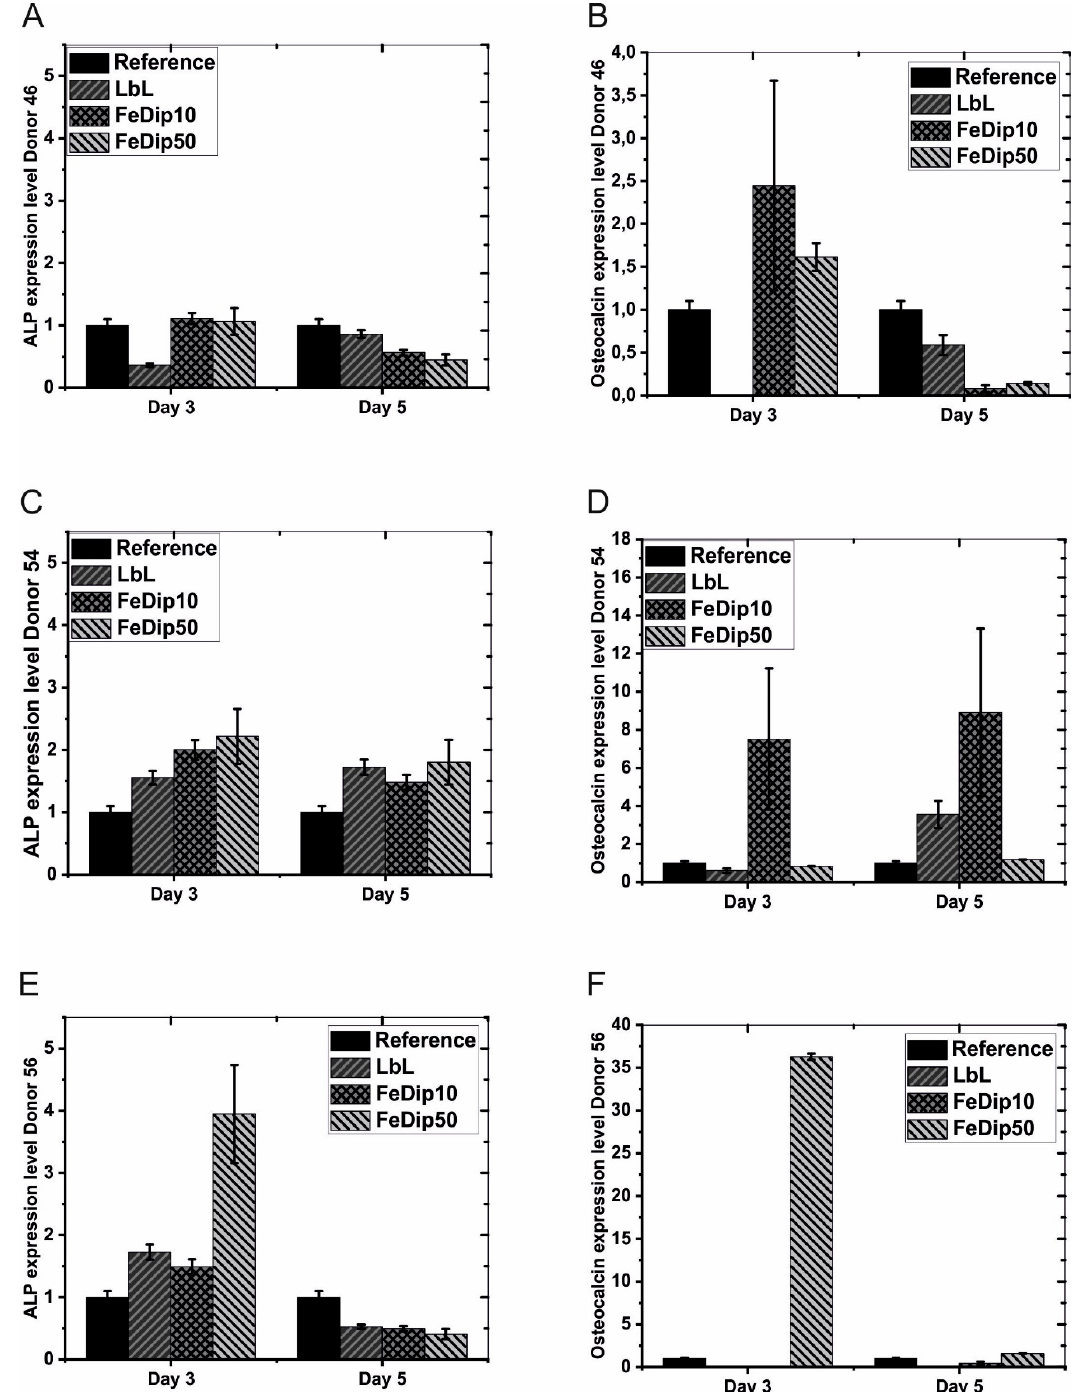
Figure 8. The bar diagrams represent values for relative ALP ( A , C , E ) and OC ( B , D , F ) expression levels of cells grown on the indicated substrates of Donor 46 (A,B), Donor 54 (C,D), and Donor 56 (E,F). All values are normalized to GAPDH expression levels. Subsequently the levels of ALP and OC expression determined for cells grown on reference substrates are set to 1. All experiments were performed in triplicate.